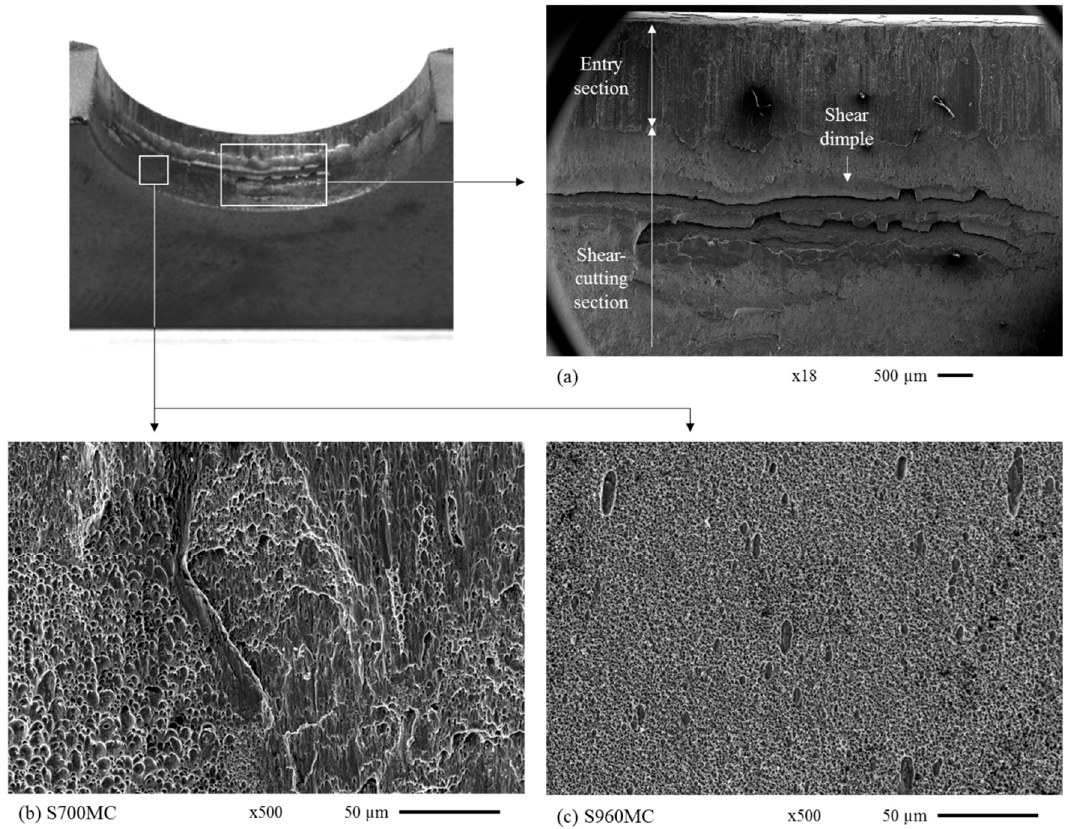
Figure 4. ( a ) SEM overview of entry and shear-cutting sections in punched holes. Below, a